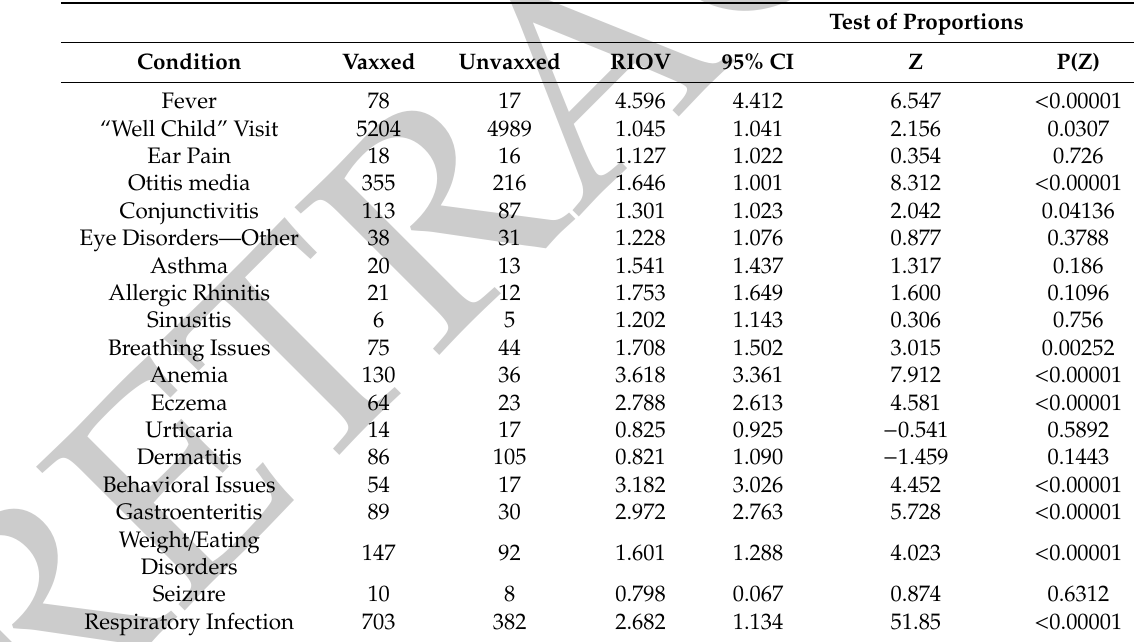
Table 3. RIOV analysis of outcomes of the vaccinated vs. unvaccinated groups, matched for Days of Care (DOC) matched comparison (N1 = 561 and N2 =